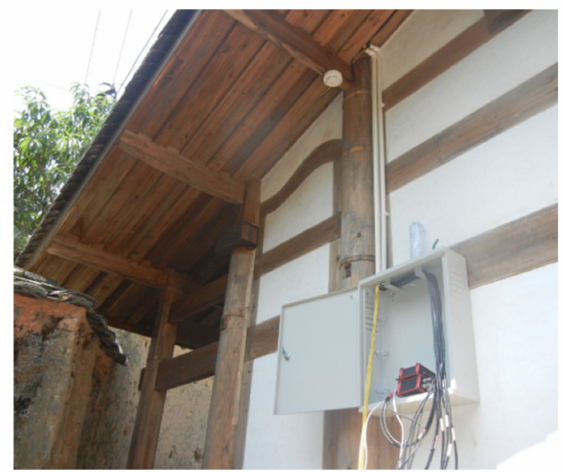
Figure 4. Terminal integrated system of the ancient timber building.